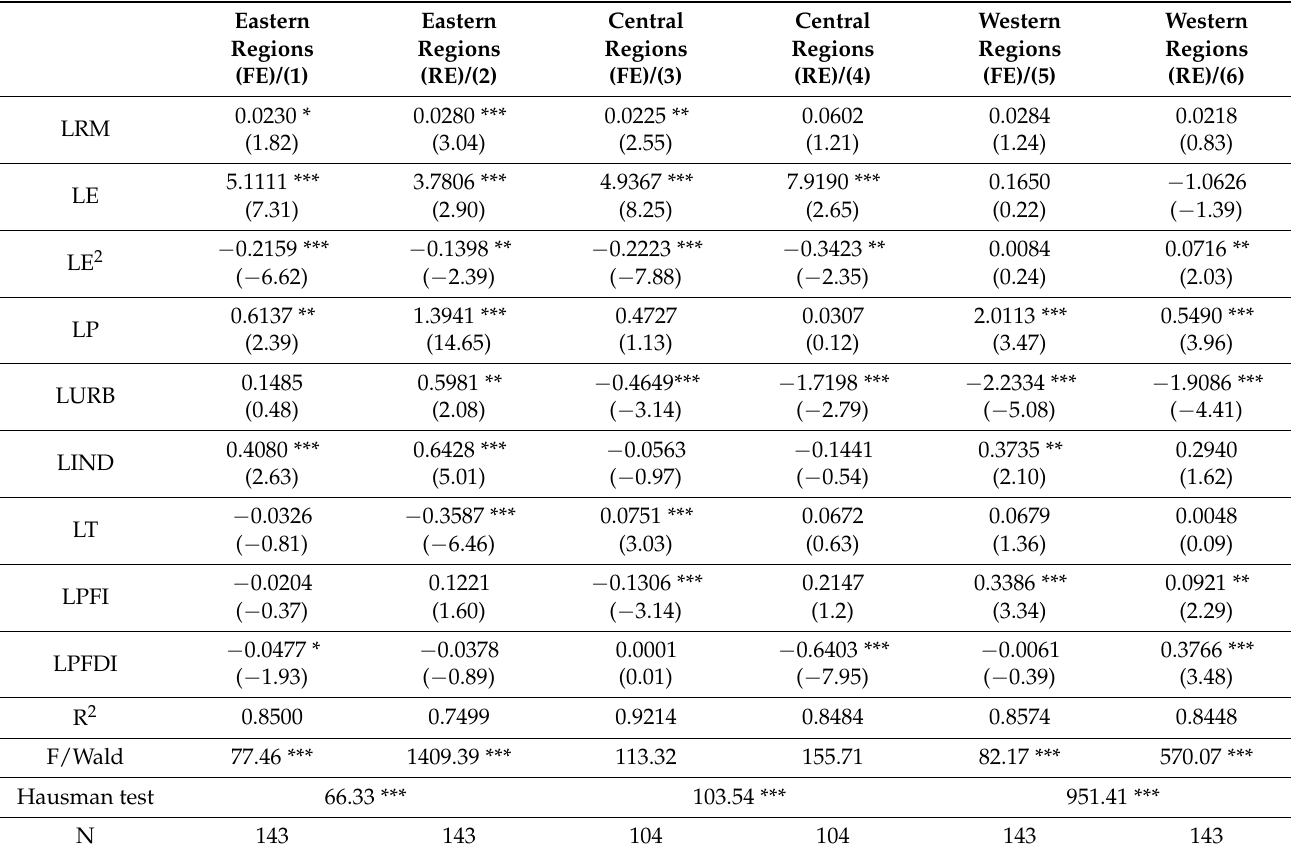
Table 5. The impact of LRM on carbon emissions by